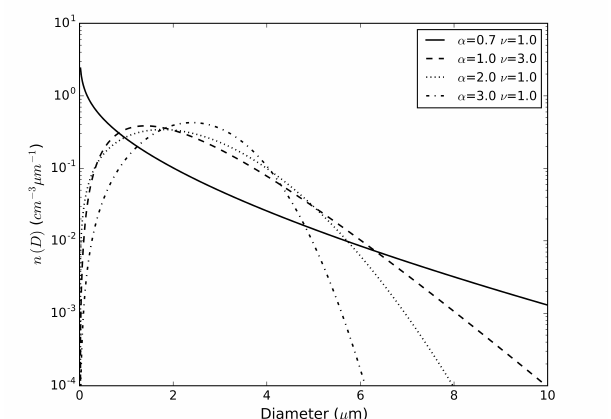
Figure 1. Examples of the generalised gamma distribution (1), with a fixed mass mixing ratio, for different values of the α and ν parameters. The selected values are used in the experiments considered in this